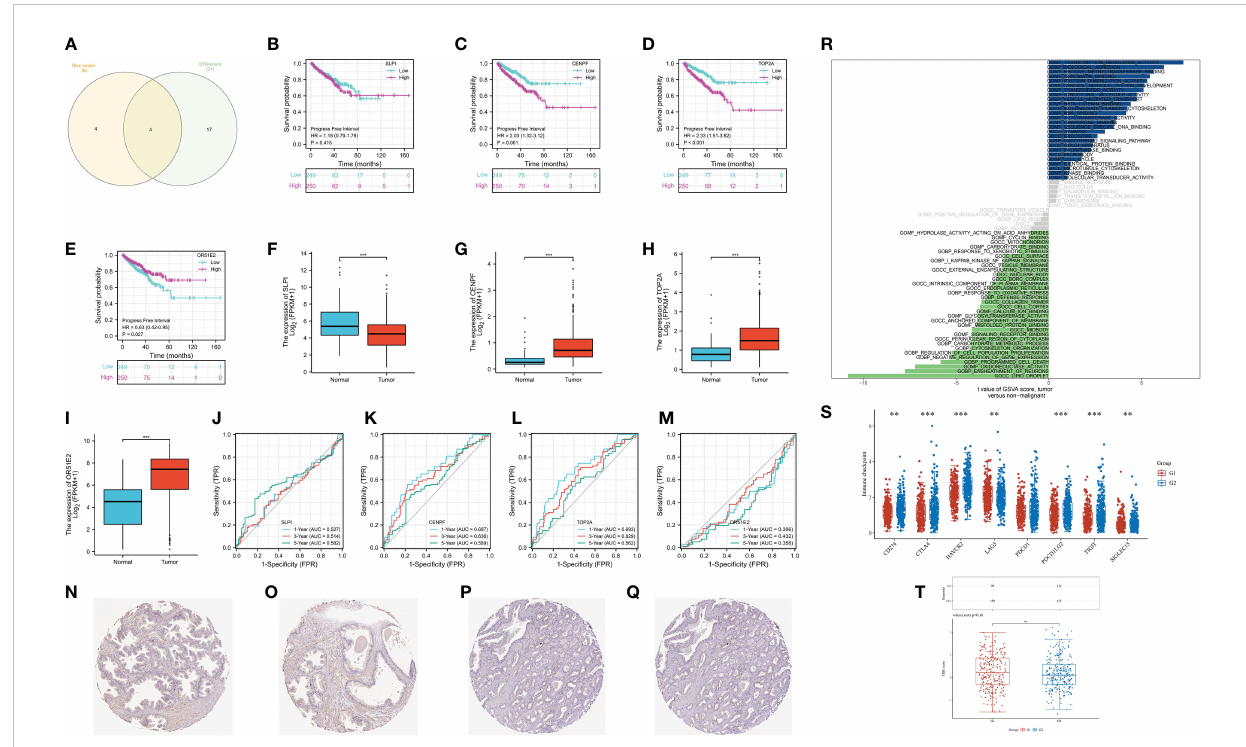
FIGURE 7 (A) The Venn diagram demonstrated the key genes involves in differentially expressed genes and CAFs-related genes; (B) The survival analysis of SLPI; (C) The survival analysis of CENPF; (D) The survival analysis of TOP2A; (E) The survival analysis of OR51E2; (F) The expression of SLPI between normal cohort and prostate cancer cohort; (G) The expression of CENPF between normal cohort and prostate cancer cohort; (H) The expression of TOP2A between normal cohort and prostate cancer cohort; (I) The expression of OR51E2 between normal cohort and prostate cancer cohort; (J) The time-dependent ROC curve of SLPI; (K) The time-dependent ROC curve of CENPF; (L) The time-dependent ROC curve of TOP2A; (M) The time-dependent ROC curve of OR51E2; (N, O) The expression of CENPF protein in normal prostate; (P, Q) The expression of CENPF protein in prostate cancer tissues; (R) The GSVA analysis of CENPF in prostate cancer cohort; (S) The expression level of immune checkpoint-related genes between low and high-expression level of CENPF group; (T) The TIDE score between low- and high- expression level of CENPF group. **: p<0.01; ***: p<0.001, ns: p>0.05.